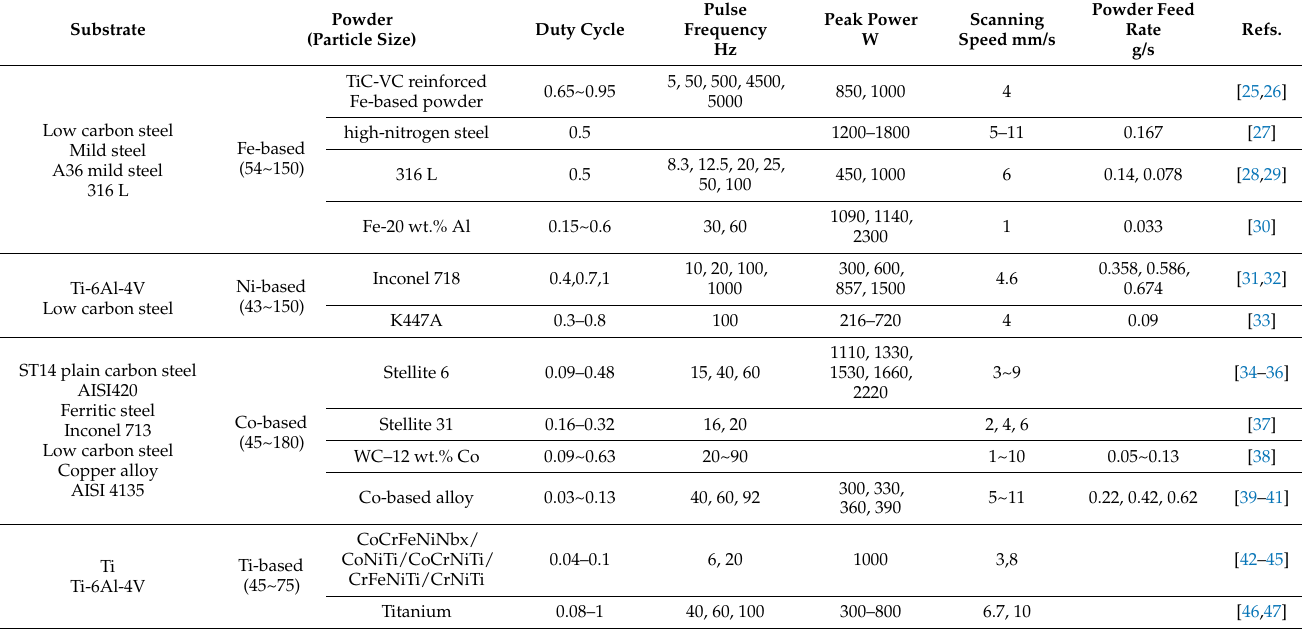
Table 1. Summary of materials used in pulsed laser material